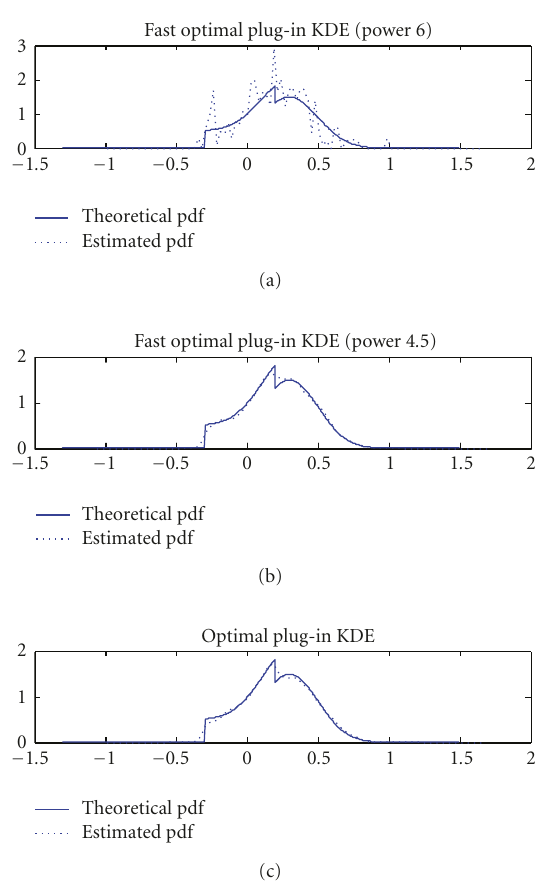
Figure 4: Bimodal pdf estimated by optimal plug-in KDE and fast optimal plug-in KDE (power 6 and